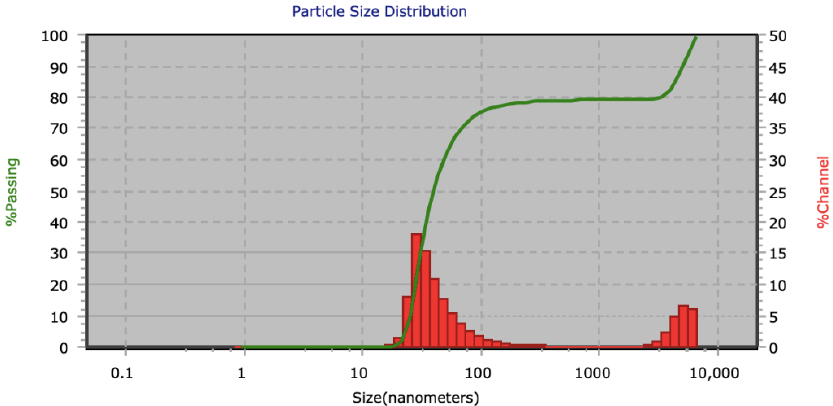
Figure 7. Particle size distribution of AuNPs-FI.